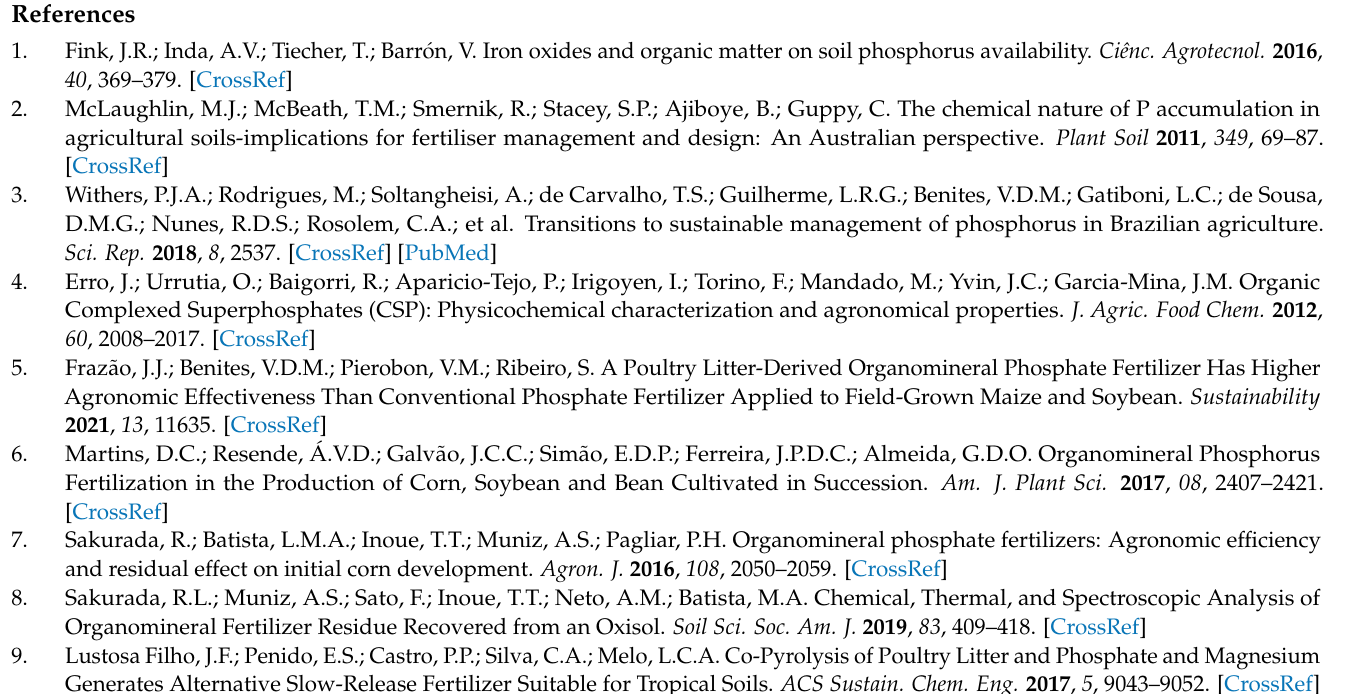
The means with standard error followed by the same letter did not differ the treatments according to the Duncan test ( p < 0.05). –P: no P fertilizer application; TSP: triple superphosphate; APR: Arax á phosphate rock. More details of the BBFs acronyms are shown in Table